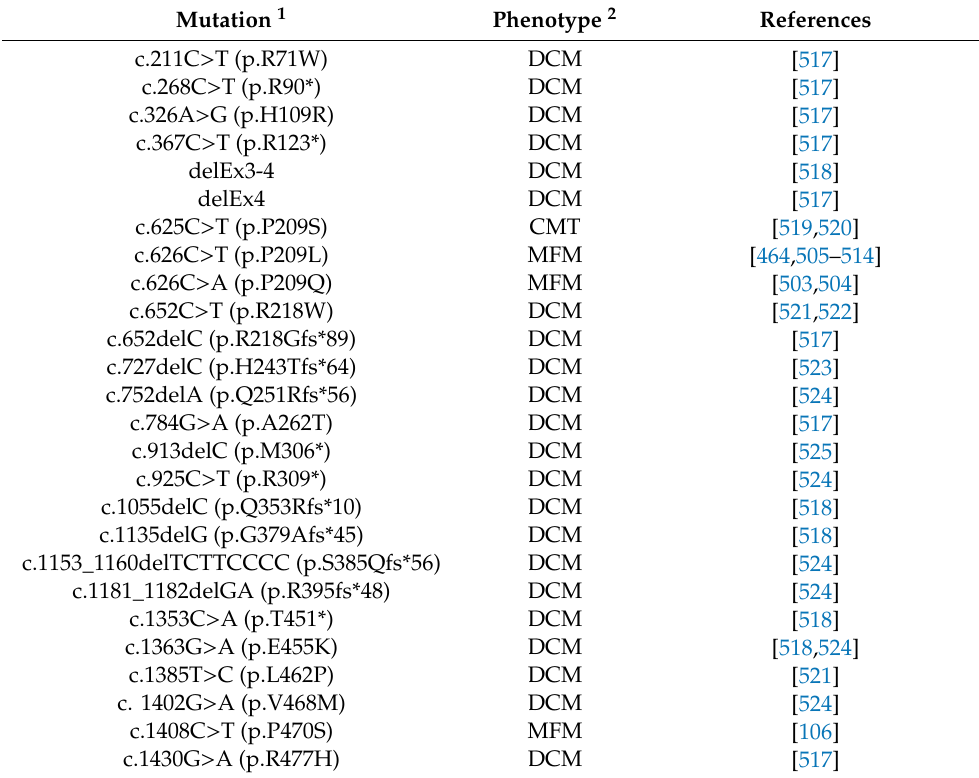
Table 9. BAG3 mutations reported to cause neuromuscular or cardiac